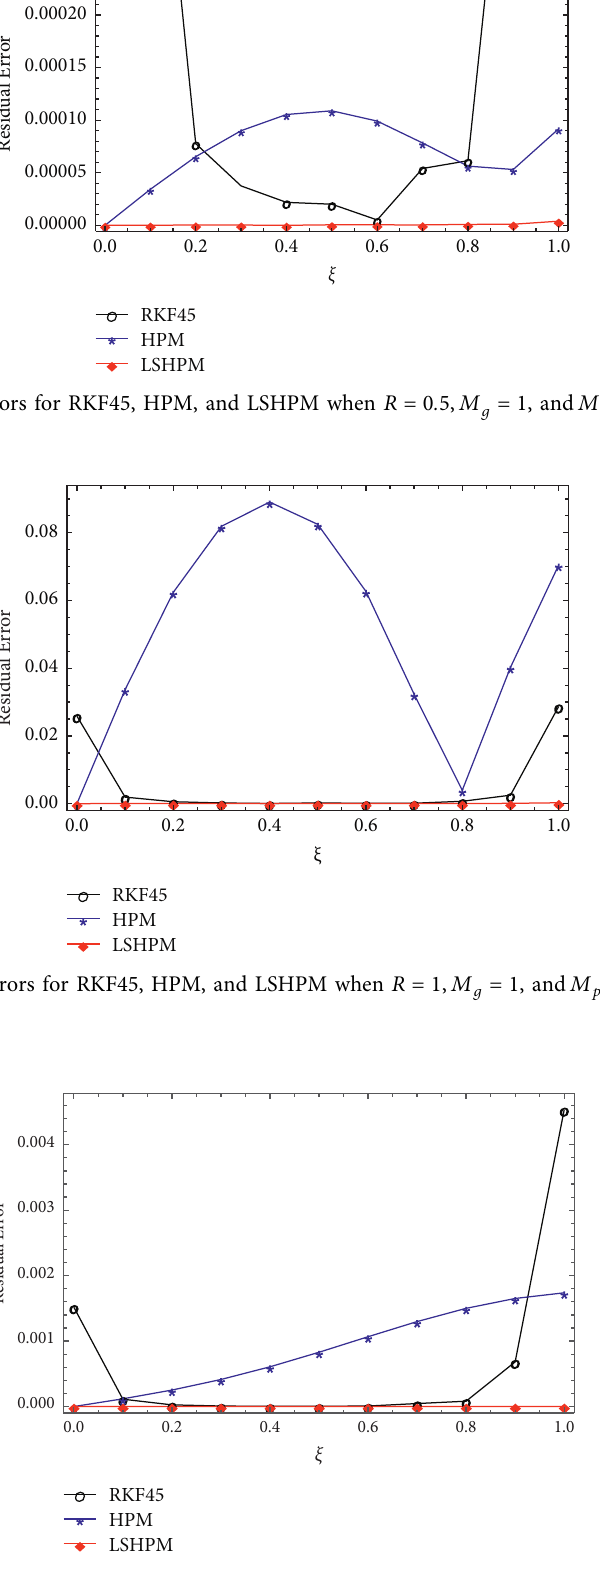
� 1 ,M � 0 . 8, and c � 0 . 9 in case of g p